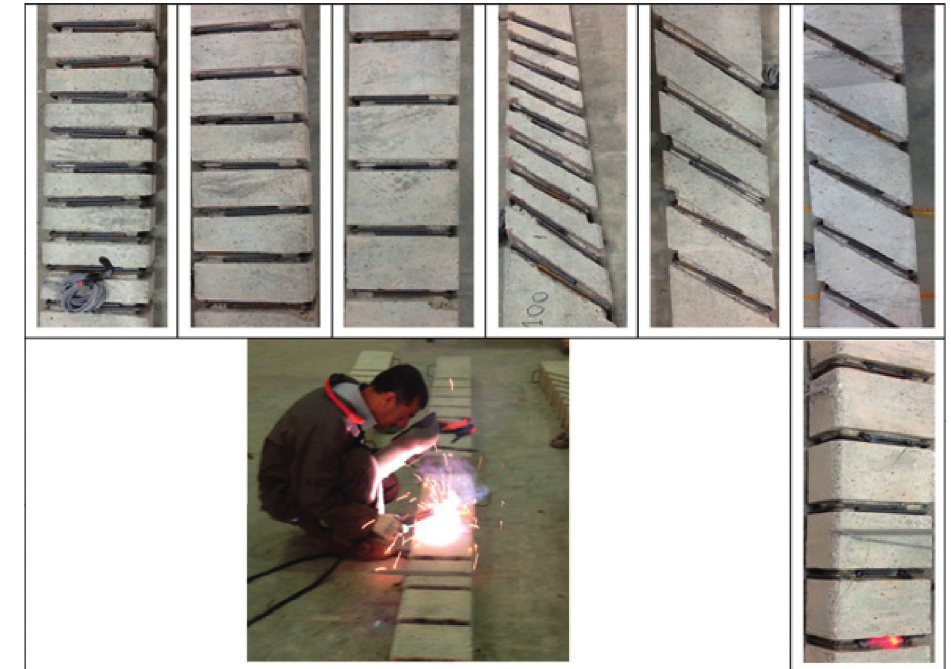
Figure 3: Two U-shaped welded conventional steel bars (Ø10mm) for each